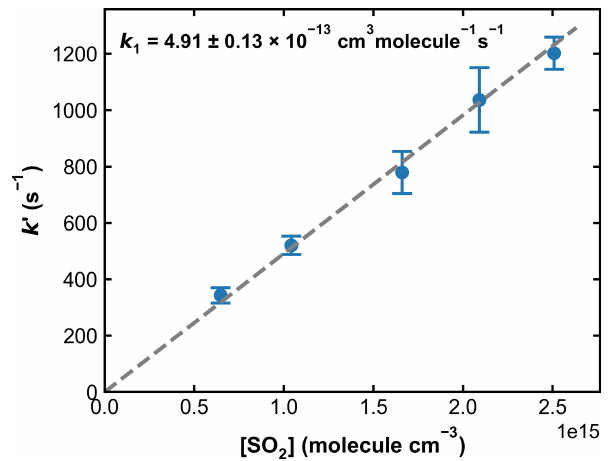
Figure 8. Pseudo-first-order rate coefficients ( k (cid:48) ) as a function of the SO 2 concentration ([SO 2 ]) at 193.2Torr N 2 and 298K. OH was generated through HONO photolysis at 351nm. Each data point is an average over four individual measurements, and the error bars represent 2 σ statistical uncertainties. k 1 was obtained from the slope of the linear regression.